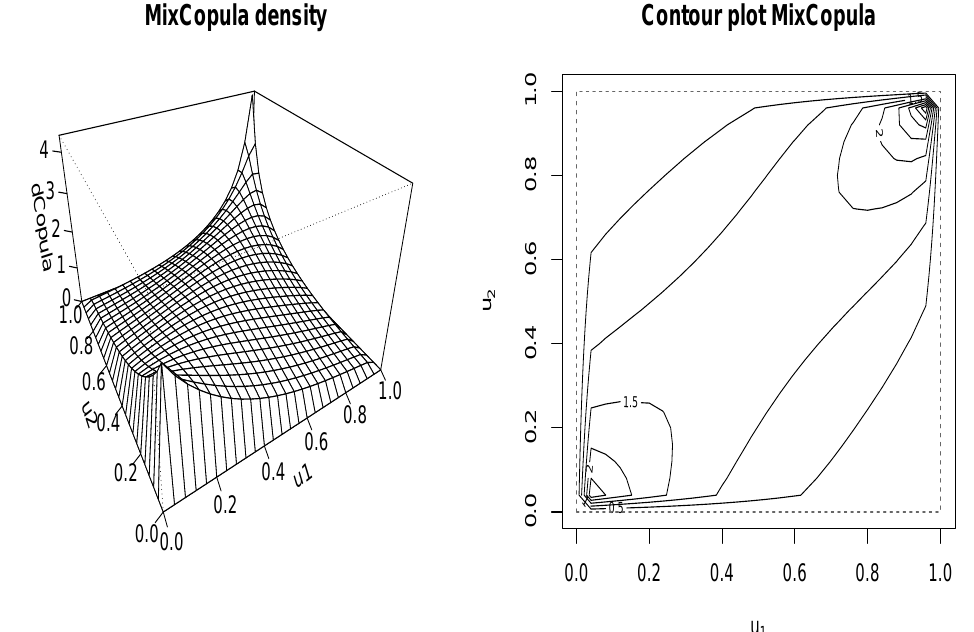
Figure 9. Top panel: Simulated standard uniform random variables under a MixCopula for GHI against temp. Bottom panel: Density and Contour plots of the joint distribution for the MixCopula of GHI against